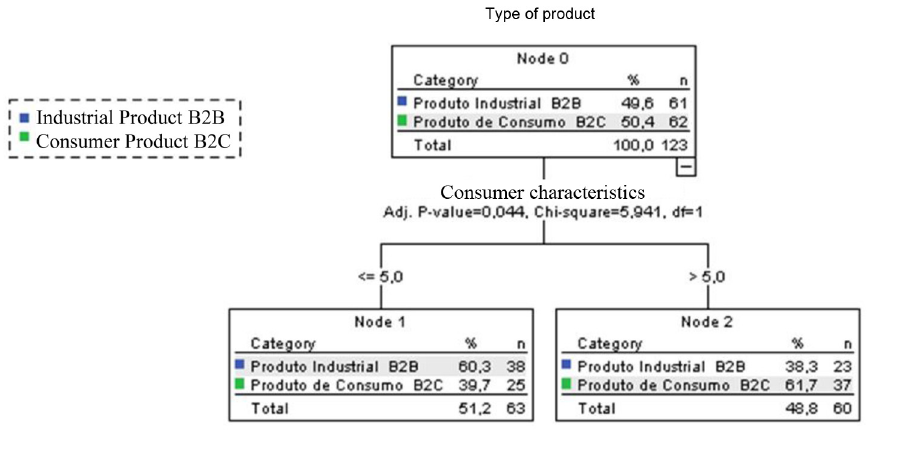
Figure 4. Classi fi cation